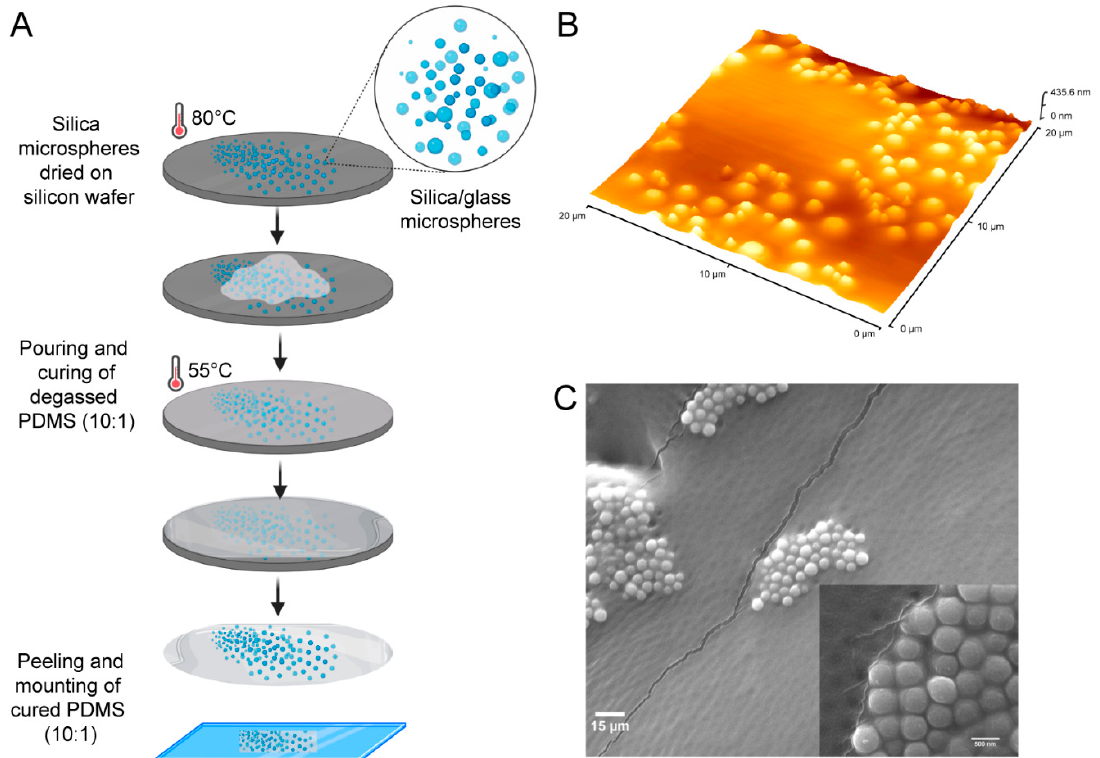
Figure 1. ( A ) Process of the fabrication of PDMS surfaces embedded with hydrophilic particles. ( B ) Topography of PDMS surface with embedded hydrophilic particles. ( C ) SEM image of the surface of PDMS with aggregates of beads.